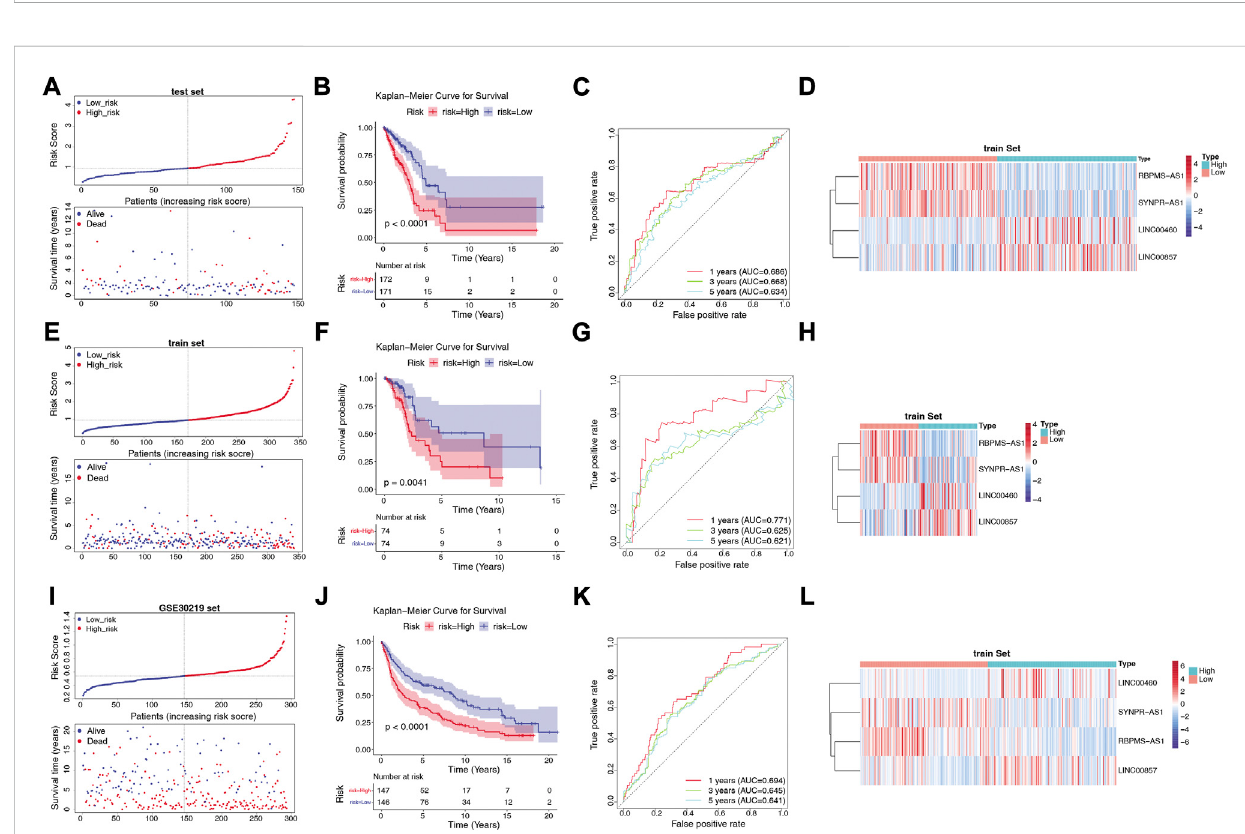
FIGURE 4 Construction and validation of the risk model. (A) Distribution of risk scores and distribution of OS in the LUAD sample in the TCGA training set. (B) Kaplan-MeiersurvivalanalysisofOS between thehigh-riskand low-risk groupsintheTCGA training set. (C) AUC inROC analysis of1-year, 3-year and 5- year survival time risk pro fi les in the TCGA training set. (D) Expression patterns of RBPMS-AS1, SYNPR-AS1, LINC00460 and LINC00857 in the high-risk and low-risk groups in the TCGA training set. (E) Distribution of risk scores and distribution of OS in the LUAD samples in the TCGA test set. (F) Kaplan-MeiersurvivalanalysisofOSbetweenthehigh-riskandlow-riskgroupsintheTCGAtestset. (G) AUCintheROCanalysisofriskcharacteristicsfor 1-year,3-year,and5-yearsurvivaltimesintheTCGAtestset. (H) ExpressionpatternsofRBPMS-AS1,SYNPR-AS1,LINC00460andLINC00857inthehigh- riskand low-risk groupsintheTCGA testset. (I) Distribution ofrisk scoresand distribution ofOS intheLUAD sample intheGSE30219 dataset. (J) Kaplan- Meier survival analysis of OS between the high-risk and low-risk groups in the GSE30219 dataset. (K) AUC in ROC analysis of 1-year, 3-year, and 5-year survival time risk pro fi les in the GSE30219 dataset. (L) Expression patterns of RBPMS-AS1, SYNPR-AS1, LINC00460, and LINC00857 in the high-risk and low-risk groups in the GSE30219